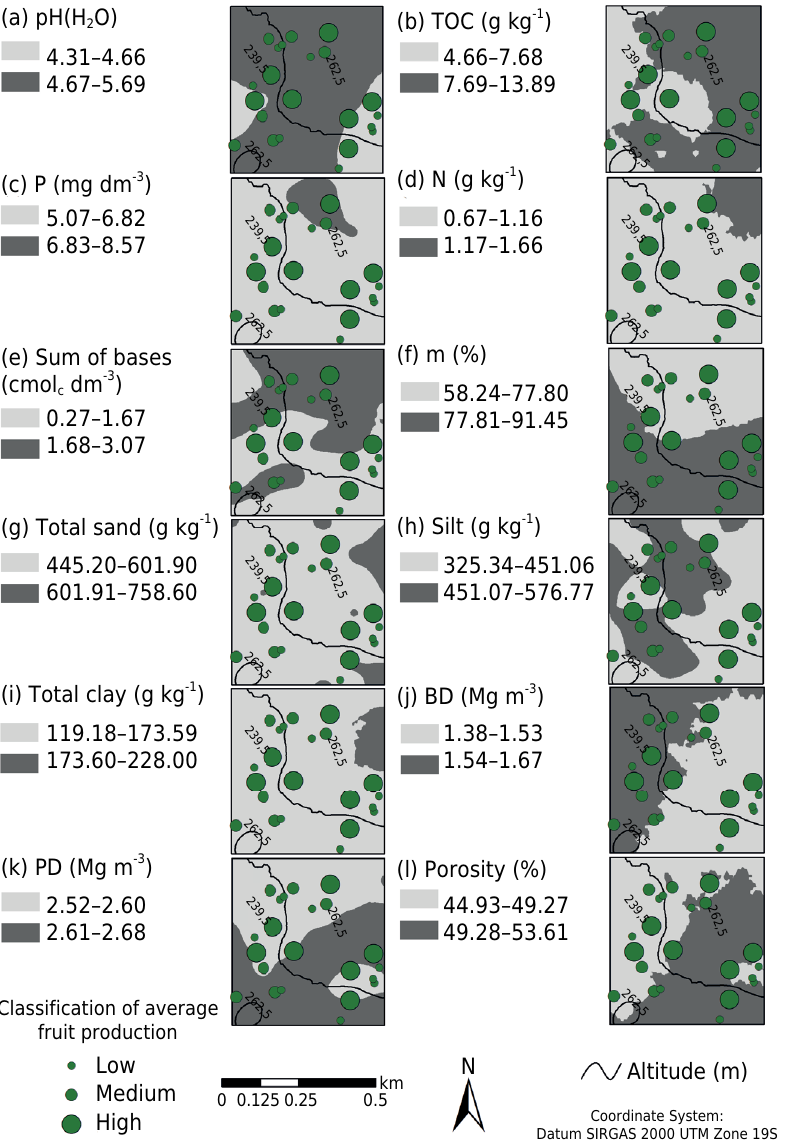
Figure 4. Spatial distribution of soil physical and chemical properties in Cachoeira - Plot 1, in the state of Acre, Brazil. Lines and values in the maps correspond to the altitude of the area, circles correspond to the average fruit production between the years 2010 and 2020, and values presented in the legends are the soil